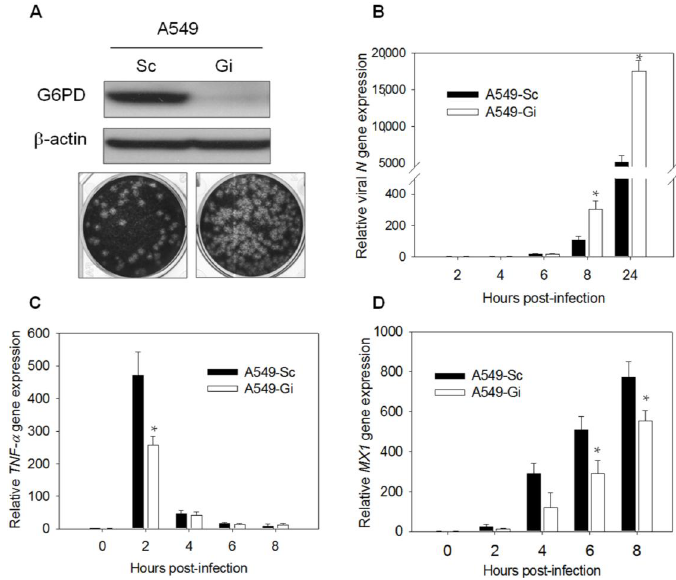
Figure 1. Expressions of antiviral gene MX1 and TNF- α decrease upon HCoV 229E infection in A549- Gi cells. ( A ) A549-Sc and -Gi cells were harvested for determination of G6PD expression by